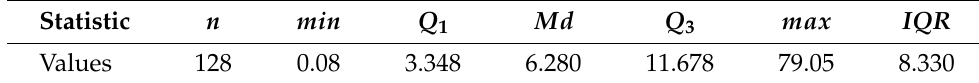
Table 9. Descriptive statistics of real